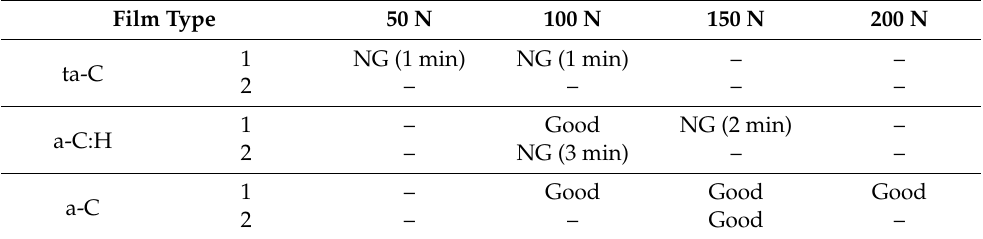
Table 4. Test results of DLC films (a-C, a-C:H, and ta-C) under multiple constant